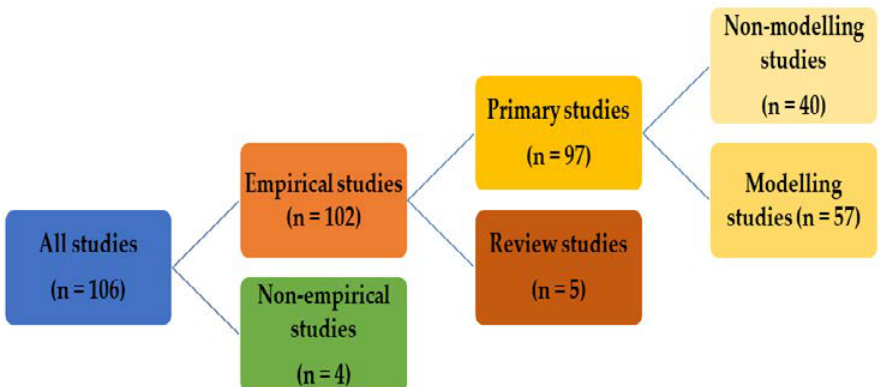
Figure 4. Subsets of the 106 studies included in the study.